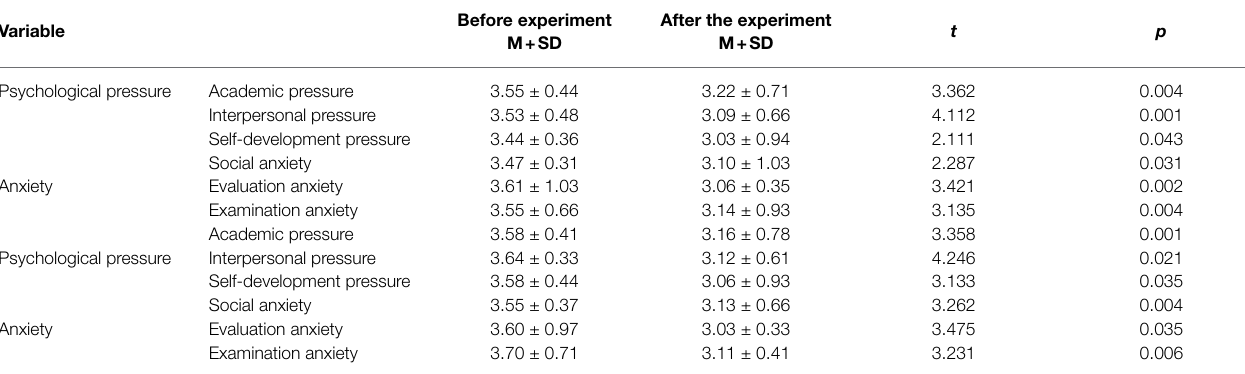
TABLE 5 | Difference analysis of psychological pressure and anxiety between males and females before and after the experiment. Variable